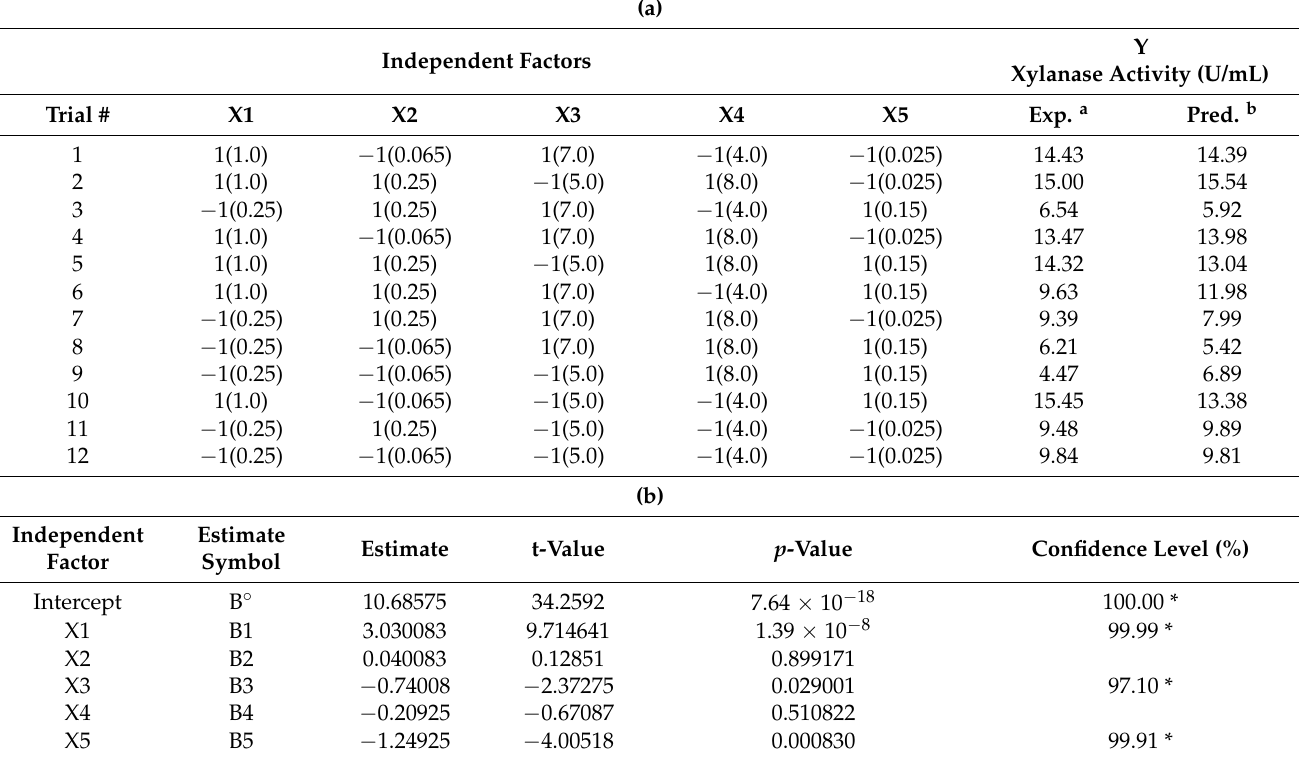
Table 1. ( a ) Coded-real values of five factors in PBD for observing top significant factors regulating the production of xylanase by P. chrysogenum strain A3 DSM105774. ( b ) An outline for multiple linear regression of PBD data for assessment of the production of xylanase by P. chrysogenum strain A3